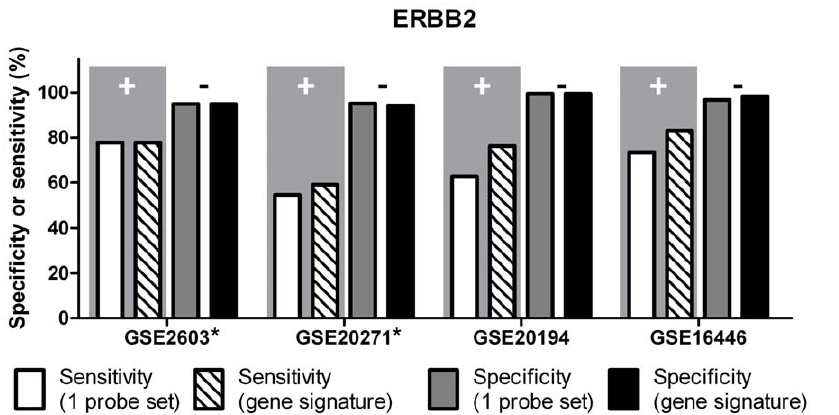
Figure 4. ERBB2 status determination: sensitivity (‘ + ’) and specificity (‘-’) obtained with two different microarray-based methods. The improved feature is highlighted by gray background. Datasets GSE2603, GSE20271 and GSE20194 were profiled on HG-U133A GeneChips;